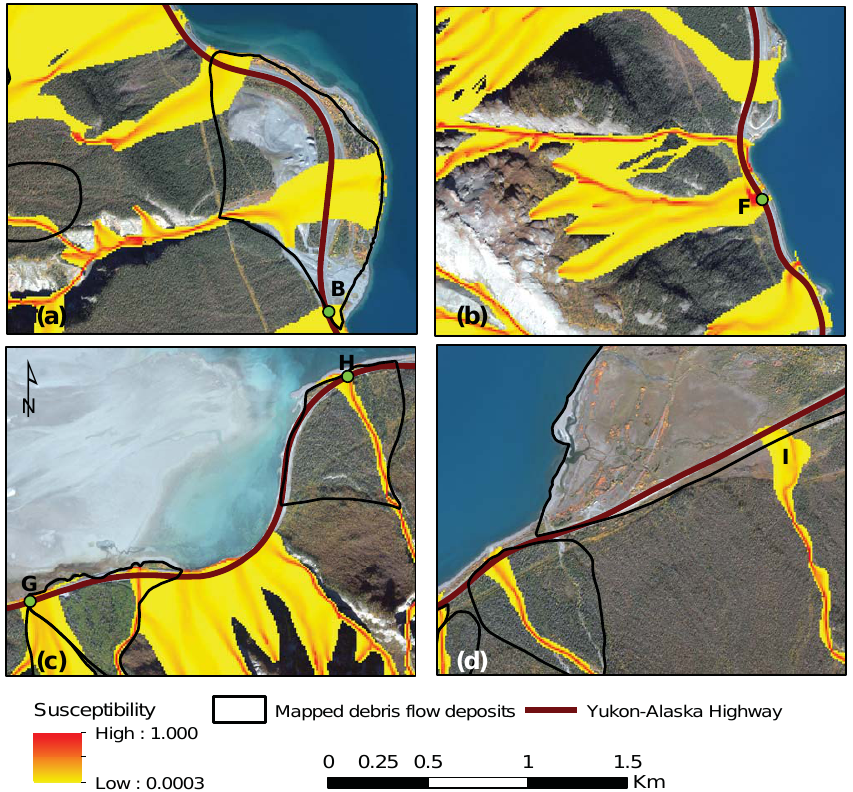
Figure 8. (a) , (b) , (c) . The susceptibility map overlaid on WorldView2 satellite imagery (2010) shows the location of debris flow deposits which blocked the highway in 1988 (B, F, and G) and in 1967 (H). (d) A potential debris flow (I) that could reach the highway.